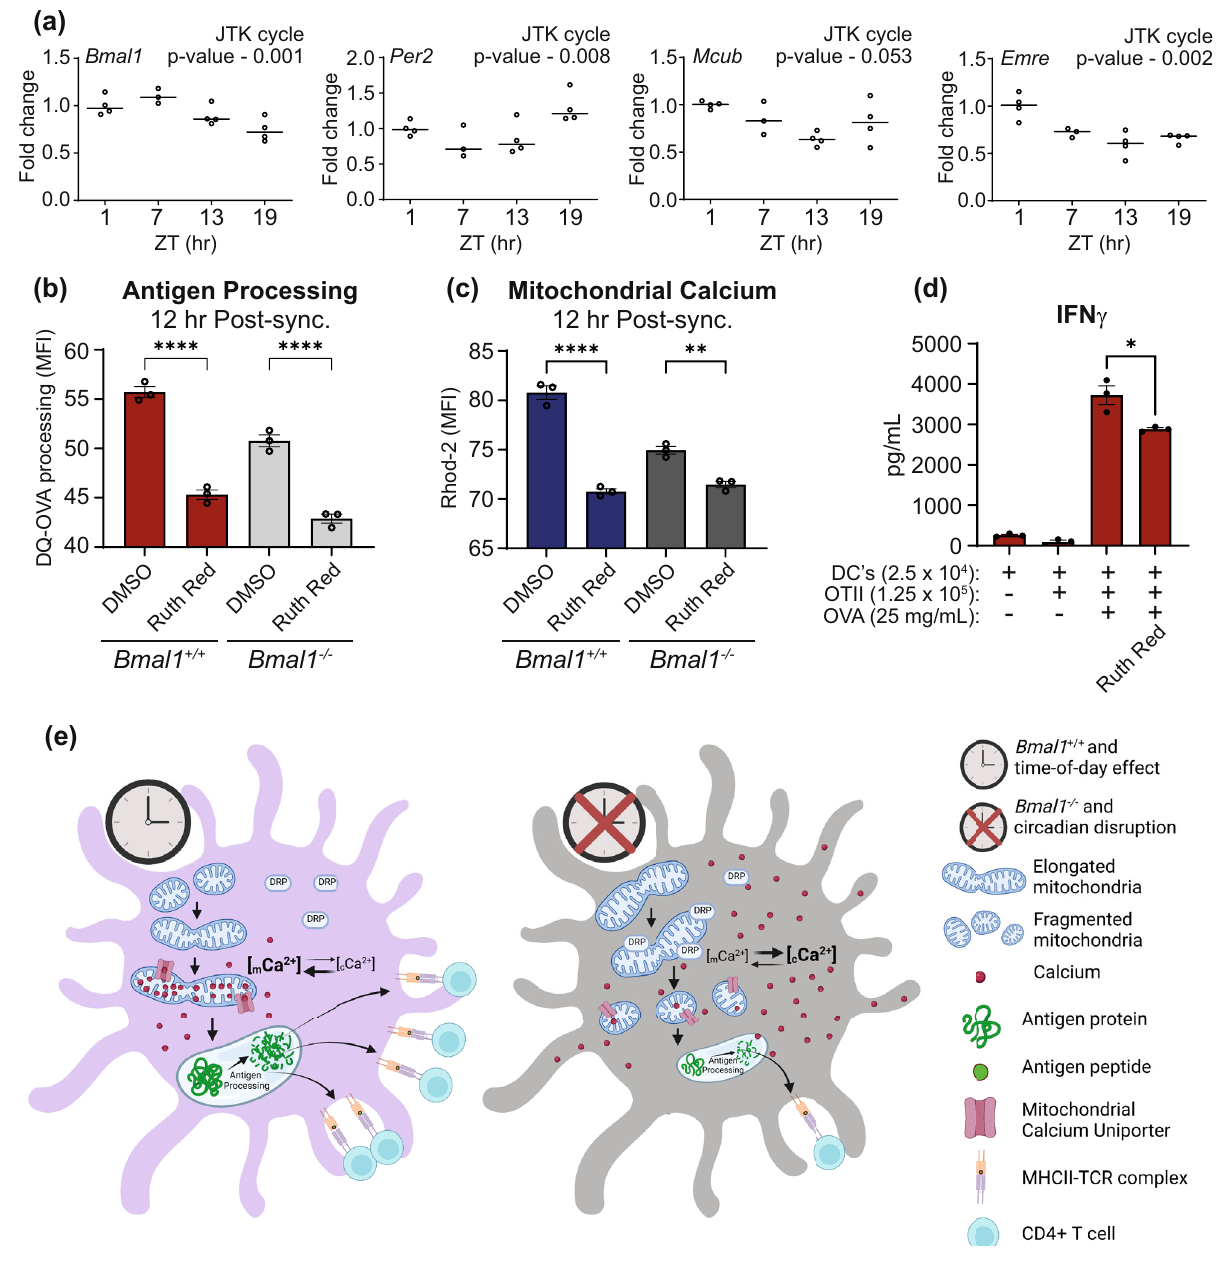
Fig. 7 | Circadian variation in mitochondrial calcium and antigenprocessing is directed via control of the mitochondrial calcium uniporter. a Spleens were isolated from WT mice at ZT 1, 7, 13 and 19. CD11c + cells were isolated and mRNA analysed by qPCR. Circadian analysis was performed using Metacycle and cycMe- thod set to “ JTK ” . P value for each gene isspeci fi ed on the graph. ( n =3 mice) ( b, c ) Bmal1 +/+ and Bmal1 − / − BMDCs were synchronised by serum shock. DQ-OVA and mitochondrial calcium uptake was quanti fi ed at 12h post synchronisation in the presence and absence of ruthenium red (5 µ M) ( n =3 biologically independent samples). d CD11c + cells were isolated from WT spleen at ZT4 and treated with